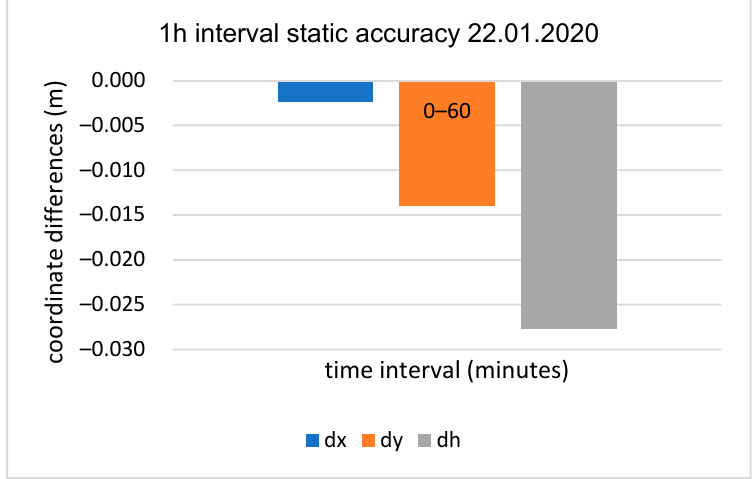
Figure 14. 30 min sub-session positioning results for the second test, baseline OPNT–P30Pro (4 km).